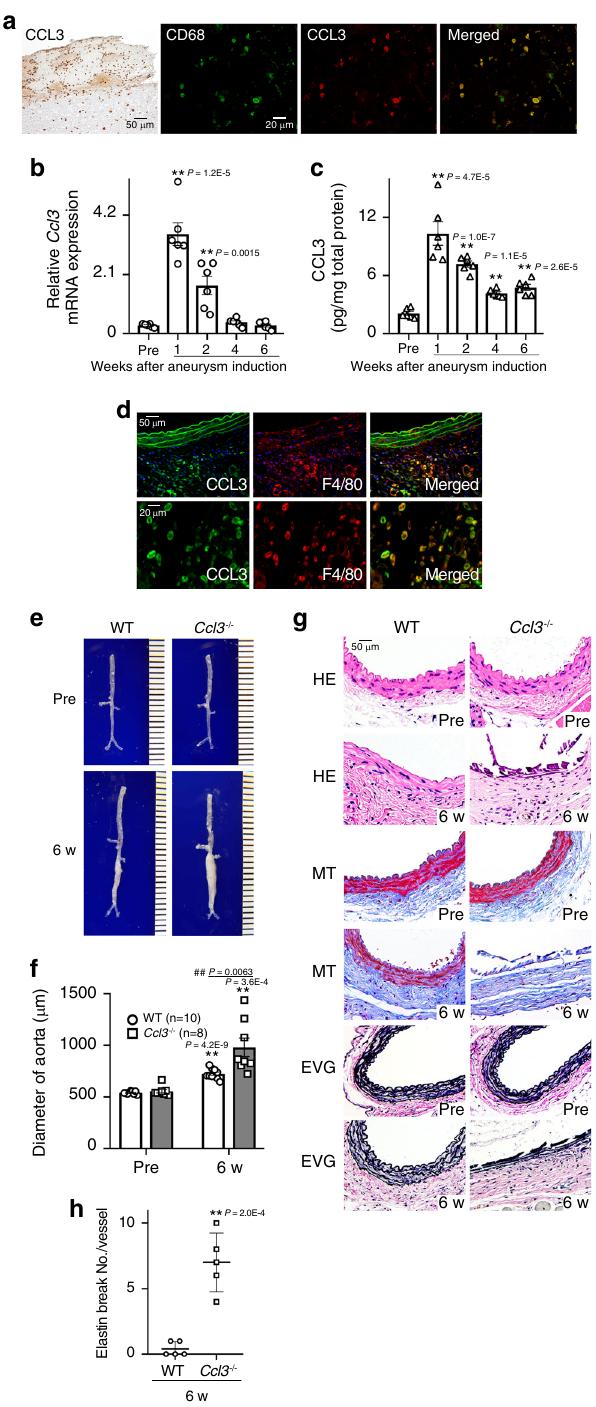
Involvement of CCL3 produced by bone marrow cells in AAA . In order to exclude the contribution of non-hematopoietic cell- derived CCL3 to CaCl 2 -induced aneurysm formation, we next applied CaCl 2 in bone marrow (BM) chimeric mice generated between WT and Ccl3 − / − mice. The mice transplanted with Ccl3 − / − mouse-derived BM cells exhibited exaggerated CaCl 2 - induced aneurysm formation together with enhanced macrophage in fi ltration and Mmp9 expression compared with those trans- planted with WT mouse-derived BM cells in both WT and Ccl3 − / − mice (Fig. 4 and Supplementary Table 3). Thus, BM cell-derived CCL3, probably macrophage-derived one, could be protective for CaCl 2 -induced AAA formation by suppressing macrophage- derived MMP-9 expression.